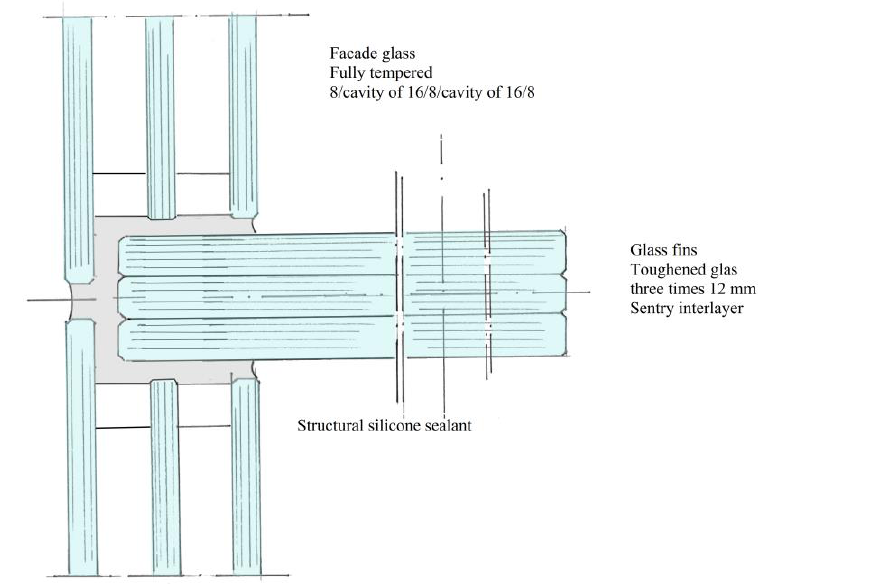
Fig. 6 mechanical scheme for stresses due to horizontal wind